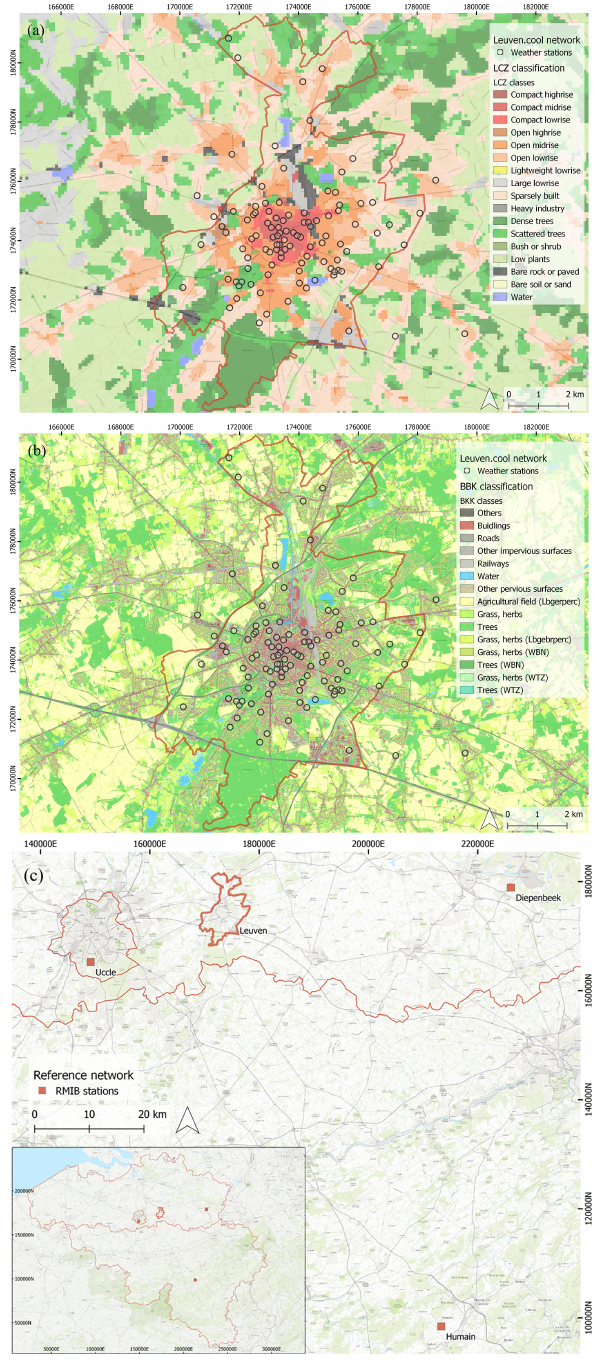
Figure 2. The Leuven.cool network (LC-X) with (a) LCZ classifi- cation and (b) BBK (Bodembedekkingskaart; land use map) classi- fication. (c) Belgium delineated by the three official regions (Flan- ders, Wallonia and Brussels) with the location of Leuven and the three RMI stations (AWSs) used in this study. The background map is from Esri (ESRI World Topographic Map,